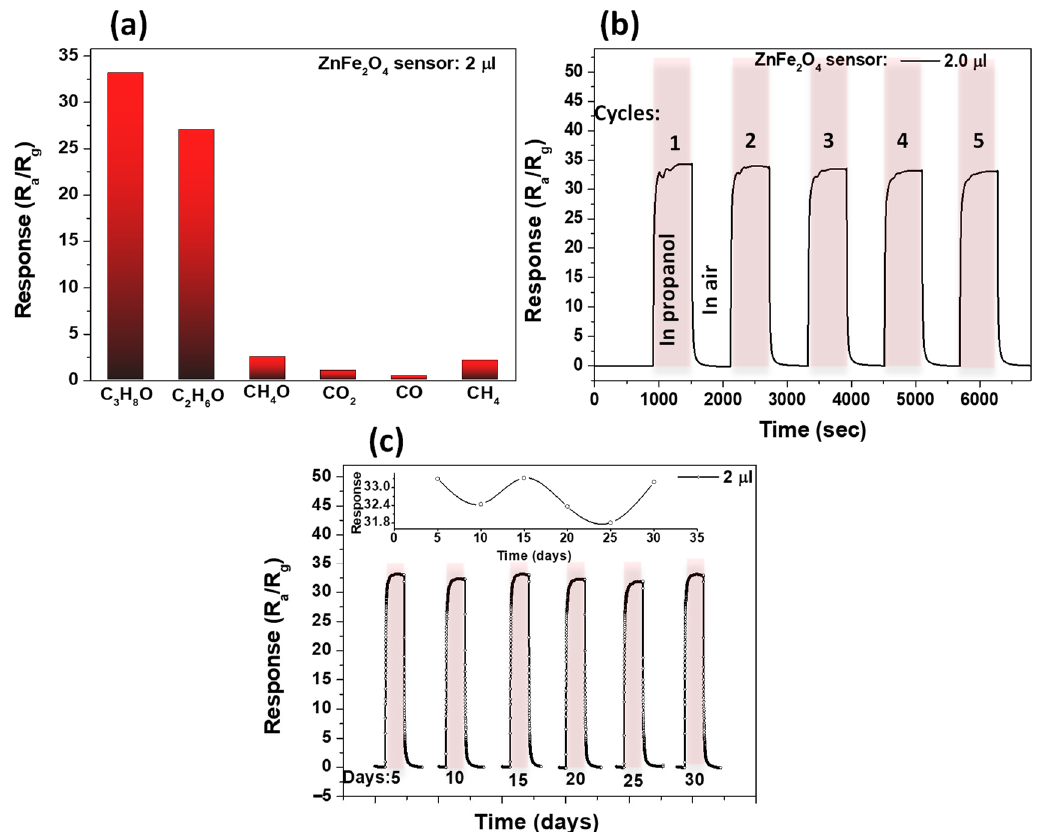
Figure 8. ( a ) Response comparison of the active ZnFe 2 O 4 NP sensing layers produced at 2.0 µL to 40 ppm propanol, ethanol, methanol, carbon dioxide, carbon monoxide, and methane at an operating temperature of 120 °C in dry air. ( b ) Reproducibility and ( c ) durability curves of the active ZnFe 2 O 4 NP sensing layer produced at 2.0 µL towards 40 ppm propanol at an operating temperature of 120 °C in dry air.